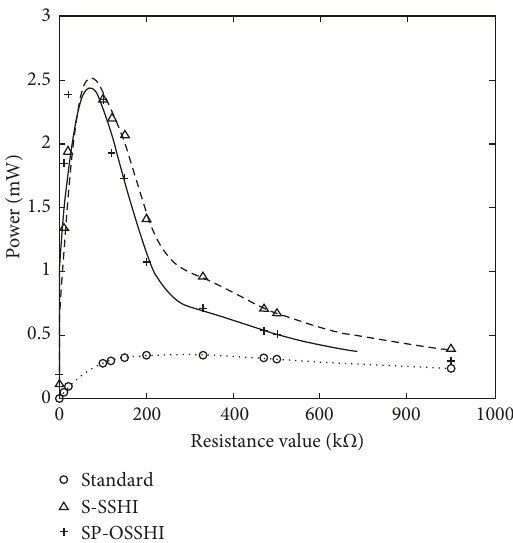
Figure 10: Three PEH circuits’ output power with different load resistance